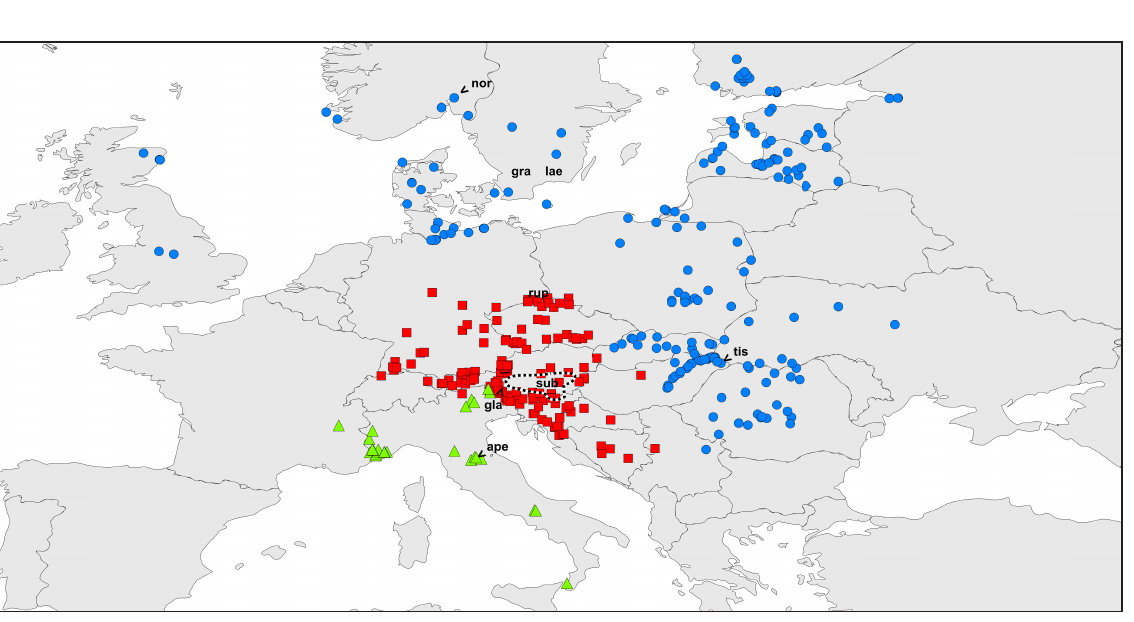
Fig. 2. Distribution of the species of the Leiobunum rupestre species group. Red squares = L. rupestre Herbst, 1799; blue circles = L. gracile Thorell, 1876; green triangles = L. apenninicum (Martens, 1969); stippled line circumscribes area of L. subalpinum Komposch, 1998. Type localities are indicated by abbreviated taxon names (ape = apenninicum ; gla = glabrum ; gra = gracile ; lae = laeve ; nor = norvegicum ; rup = rupestre ; sub subalpinum ; tis = tisciae ). Arrows indicate a specified locality, if unprecisely given, the general area is indicated ( rupestre = Saxony; gracile , laeve =